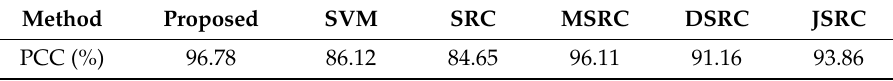
Table 9. PCCs of different methods under configuration variance.